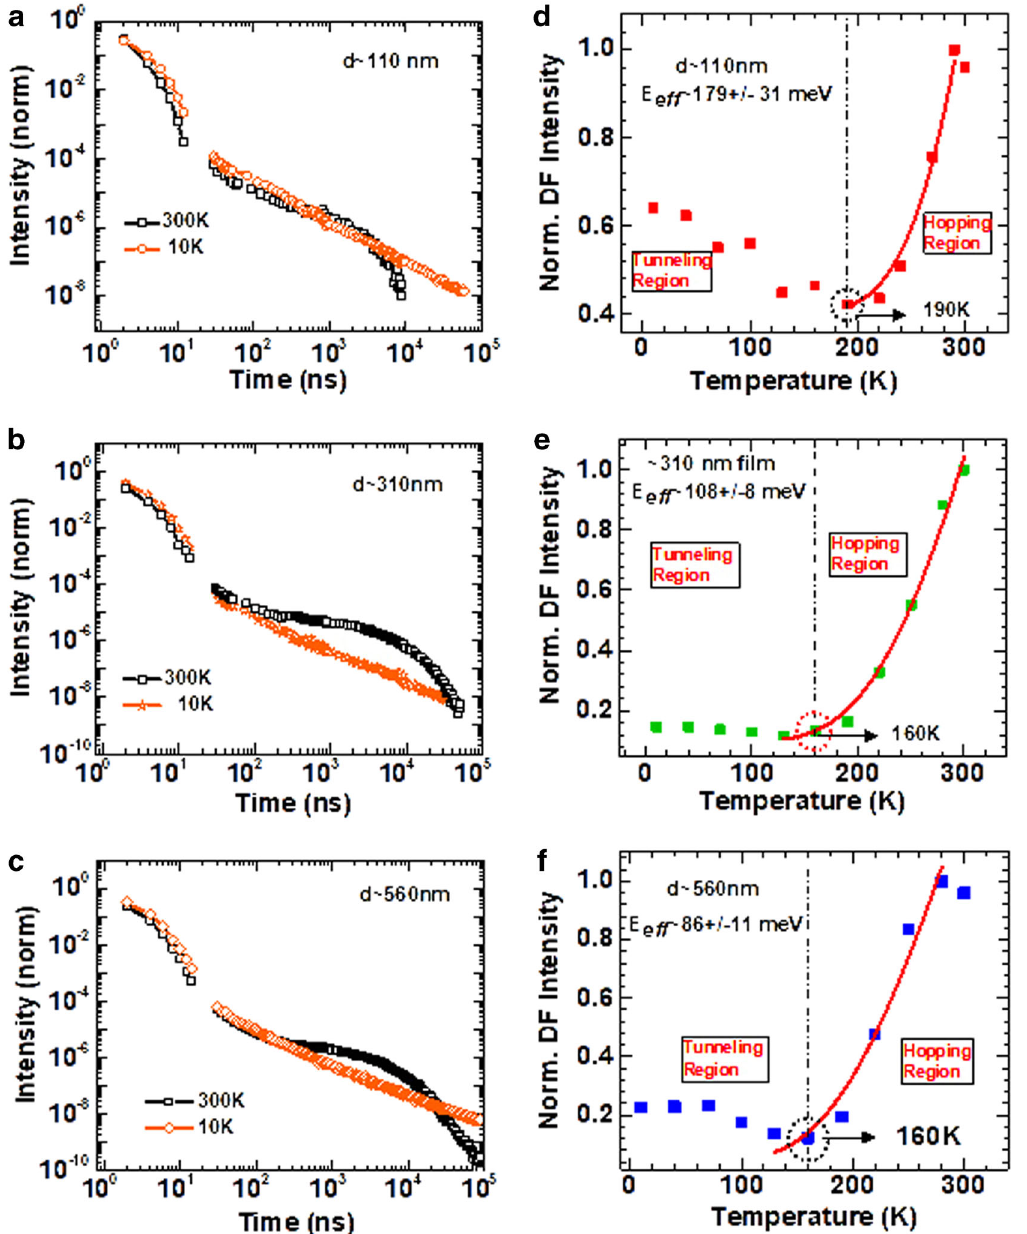
Fig. 4 Temperature-dependent DF dynamics. Temperature-dependent time-resolved PL decay for F8BT fi lms of different thicknesses. Each decay curve has a fast and a slow component. a For thinnest fi lm (~110 nm) the DF has almost remained unaffected relative to temperature, whereas for b intermediate thickness (~310 nm) and c thickest fi lm (~560 nm) studied, the DF decay dynamics change from exponential to power-law decay at lower temperatures. Time-integrated DF intensity relative to temperature for d 110 nm e 310 nm and f 560 nm-thick fi lms. The DF intensity has two different temperature dependence namely: thermally assisted hopping region and weakly temperature-dependent single step tunneling